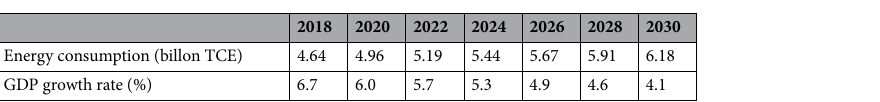
Table 8. Assumption of energy consumption and GDP